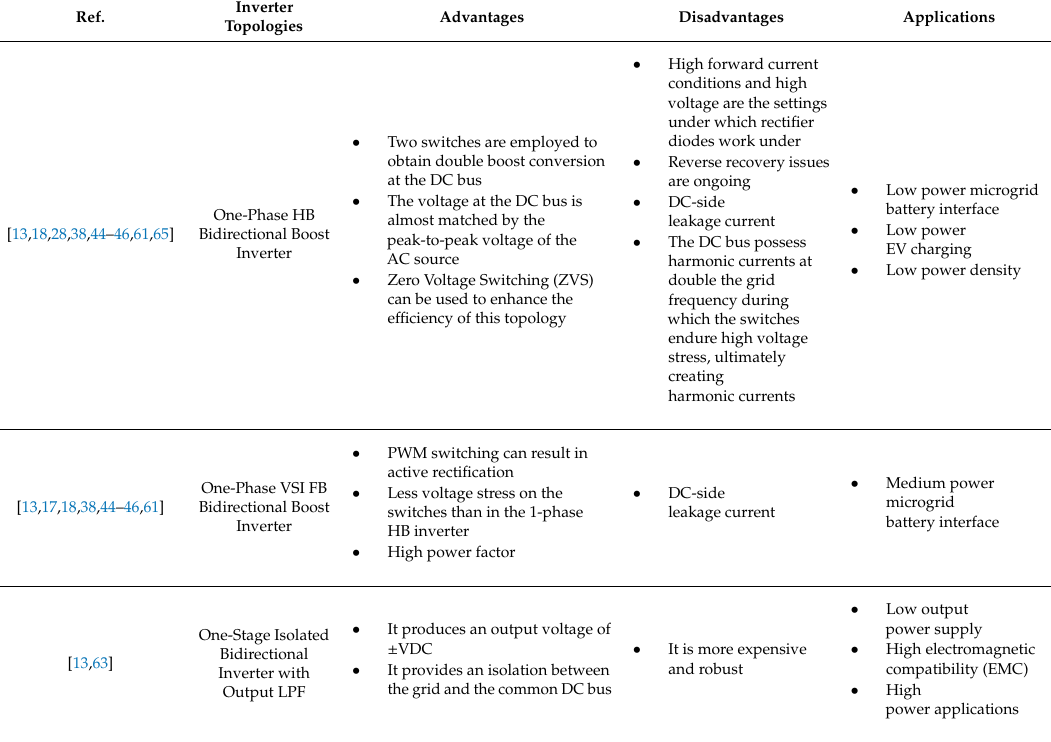
Table 3. Comparison of bidirectional AC–DC inverter topologies.